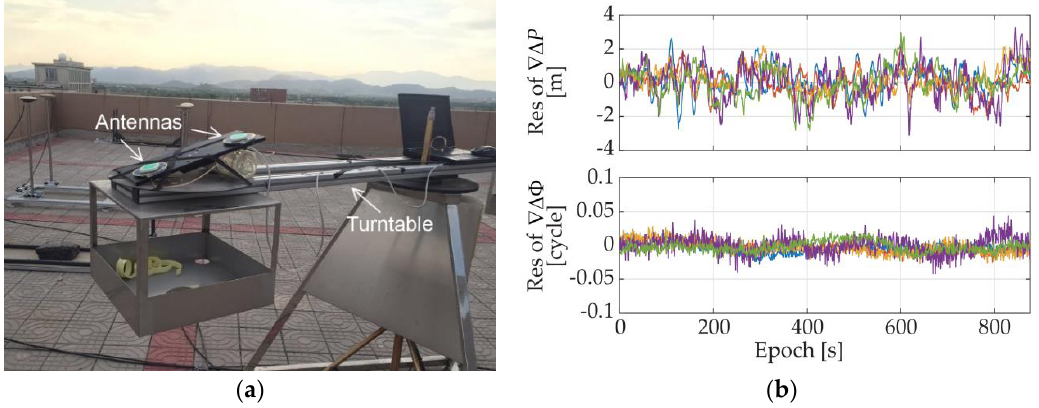
Figure 8. ( a ) Open area environment; ( b ) DD measurements residuals under open area.